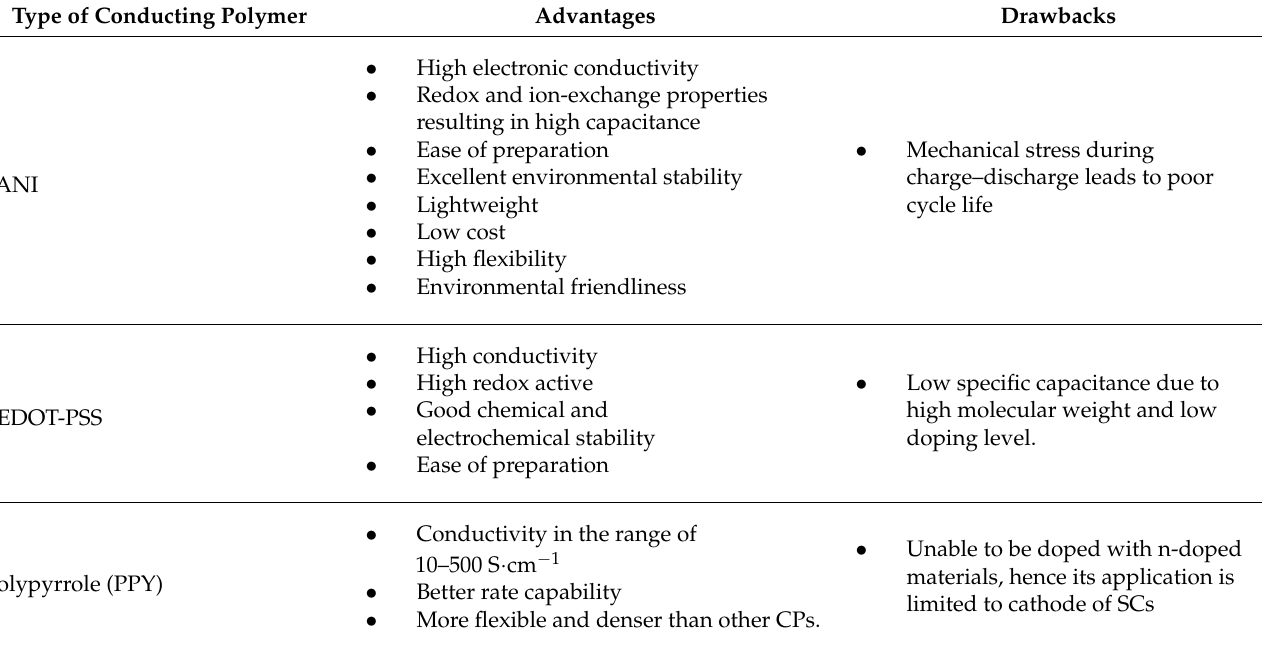
Table 2. Comparison of different conductive